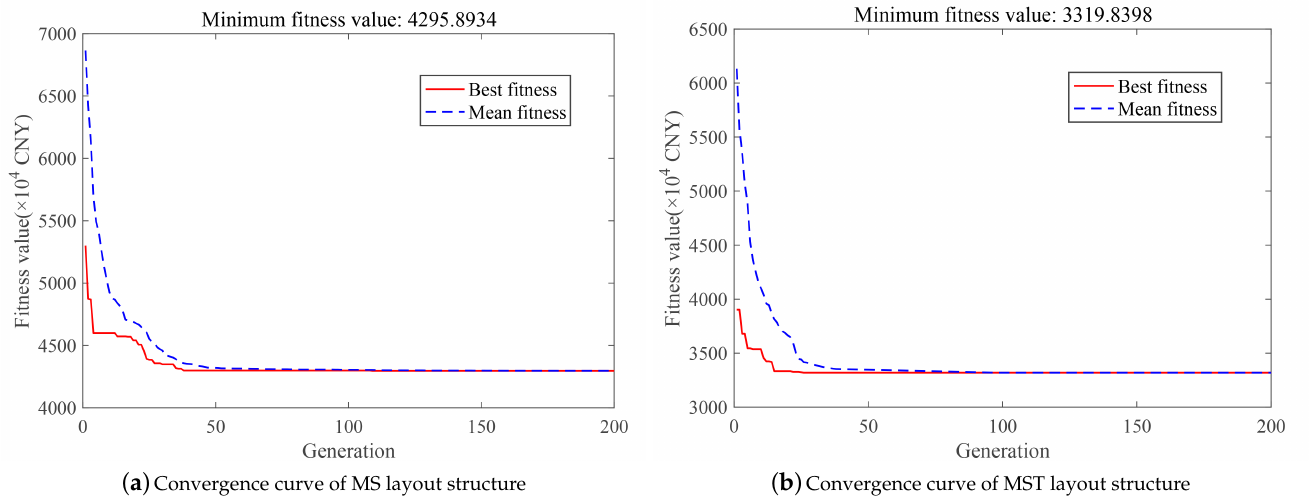
Figure 6. Convergence curves of the hybrid optimization algorithm with two layout